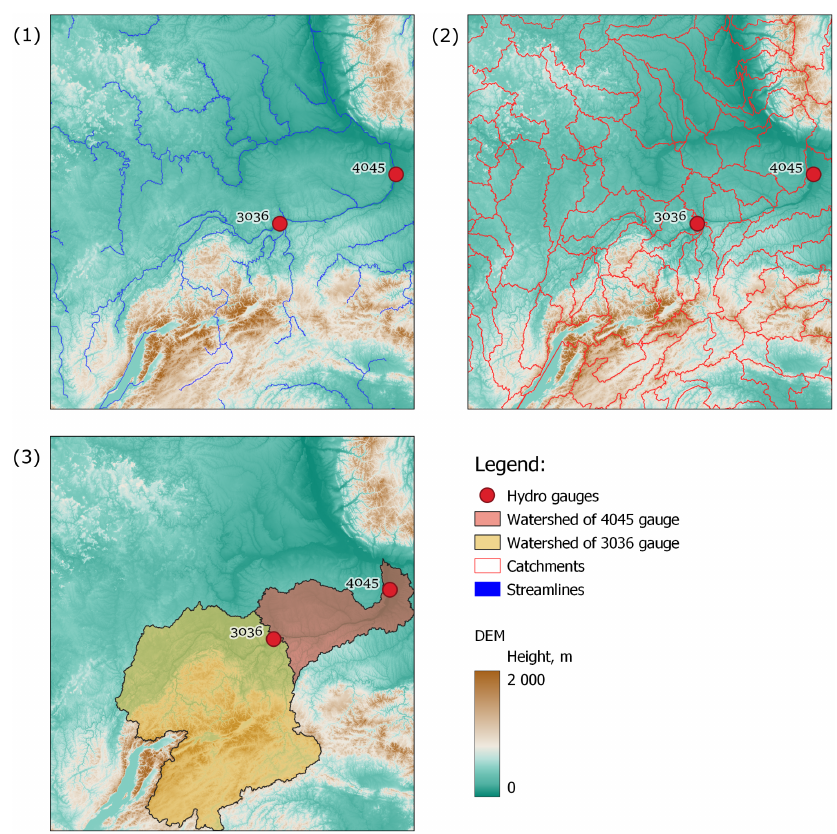
Figure 12. Steps of watershed segmentation. ( 1 ) streamlines, generated on relief model; ( 2 ) catchment segmentation for each tributary; ( 3 ) watershed segmentation for hydro gauges 3036 and